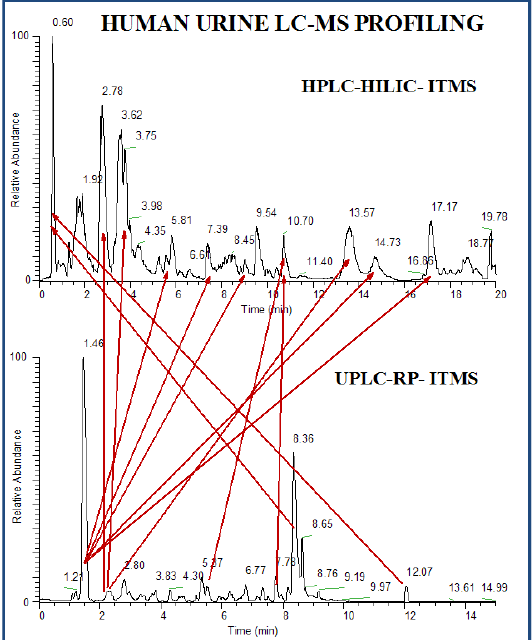
Figure 6. Comparison of LC-MS chromatograms of human urine sample acquired in RP and HILIC liquid chromatography modes on LTQ (linear ion trap mass spectrometer).